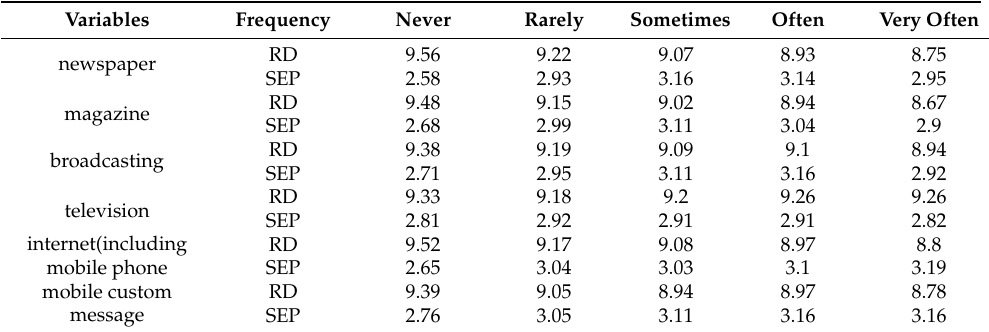
Table A4. Mean of individual-level income inequality and subjective environmental pollution for the respondents that use different media and have different use frequency.